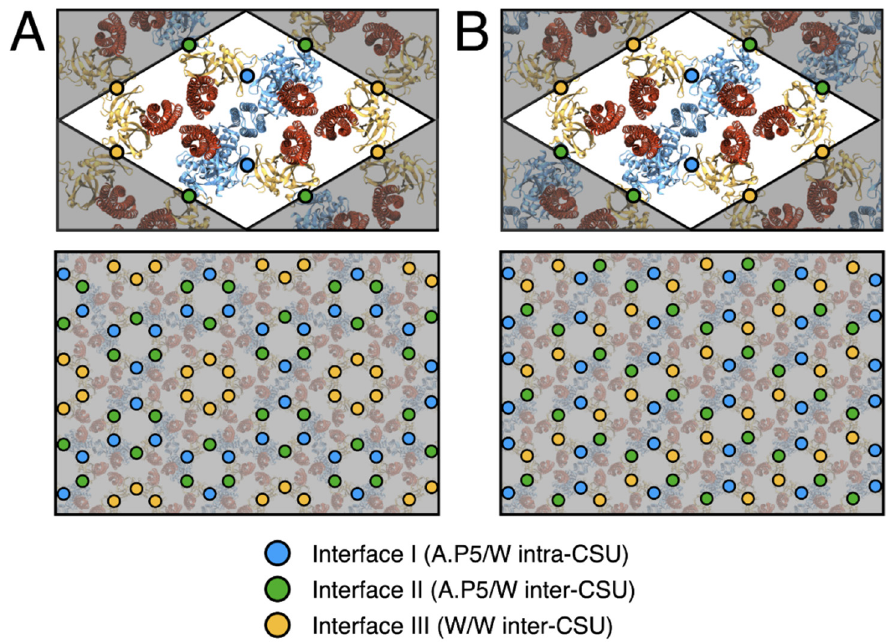
Figure 5. Assembly interfaces of p6 and p2 chemosensory array architectures. ( A ) The p6 array architecture. ( B ) The p2 array architecture. The positions of assembly interfaces I (A.P5/W intra-CSU), II (A.P5/W inter-CSU) and III (W/W inter-CSU) are depicted in blue, green and yellow, respectively. For each architecture the spatial distribution is depicted around one CSU (top) and a larger assembly of CSUs (bottom).